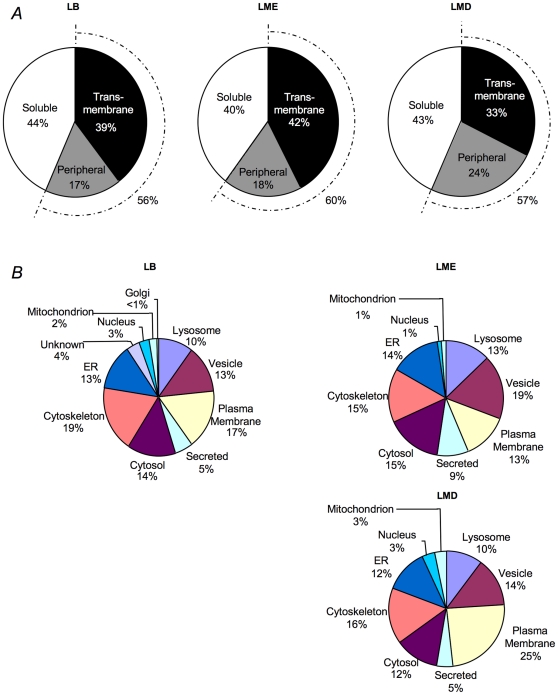
Characteristics of LB proteome.(A) Distribution of membrane proteins in the proteome with respect to the 3 LB fractions. (B) Predicted subcellular localization of proteins in the LB, LMD and LME fractions.